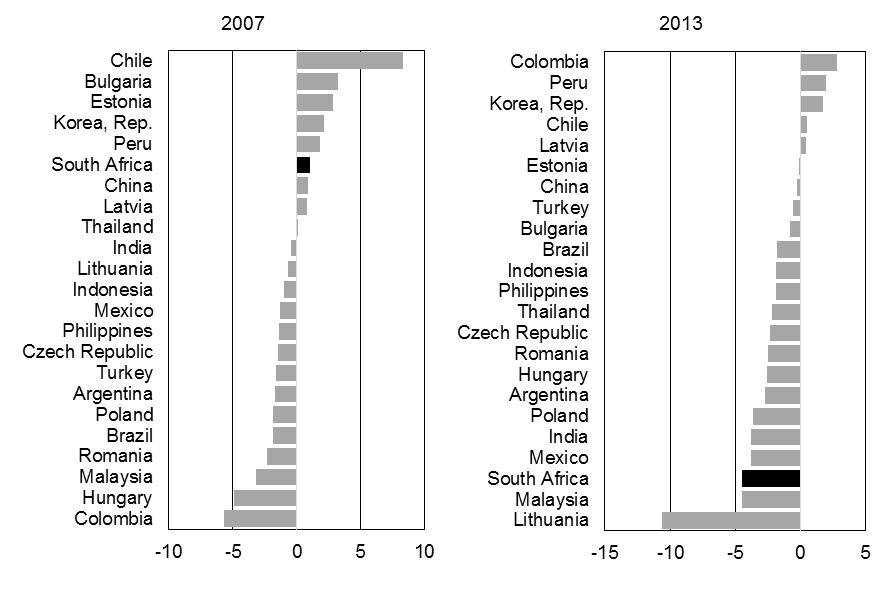
FIGURE 4: Fiscal balance (% of GDP) Source: Authors’ depiction of data from The World Bank: World Development